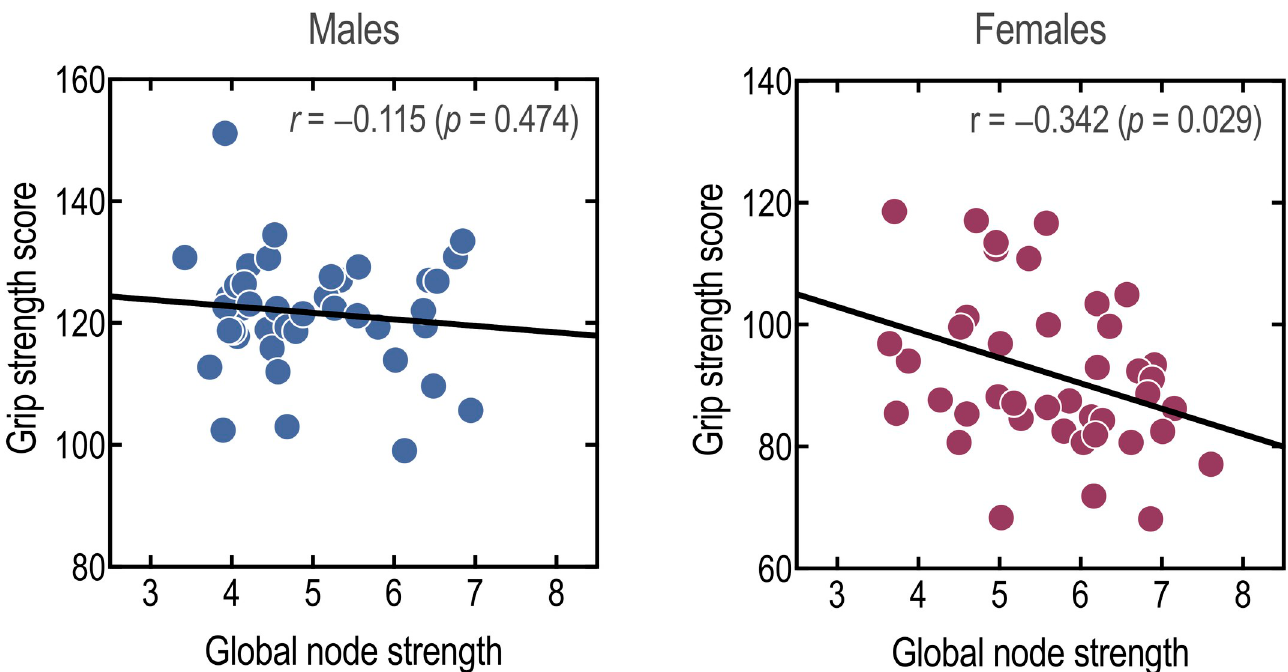
Fig 4. Correlation analysis between the parietal network global node strength and grip strength in males and females.